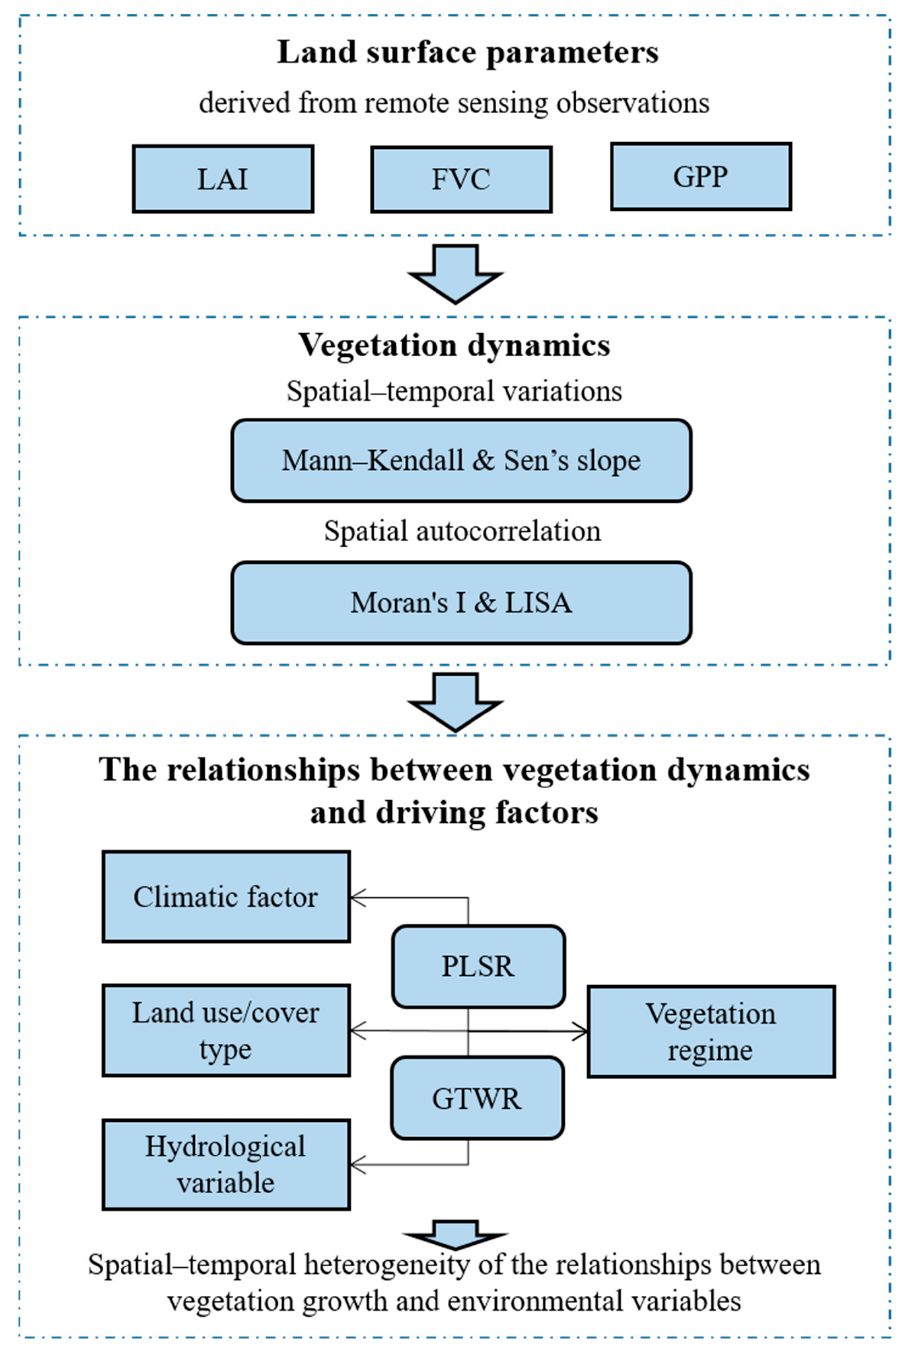
Figure 2. Flowchart of investigating the spatial-temporal vegetation dynamics and their relationships with climatic, anthropogenic, and hydrological factors in the Amur River Basin (ARB). PLSR: partial least squares regression; GTWR: geographical and temporal weighted regression; LISA: local indicators of spatial association.